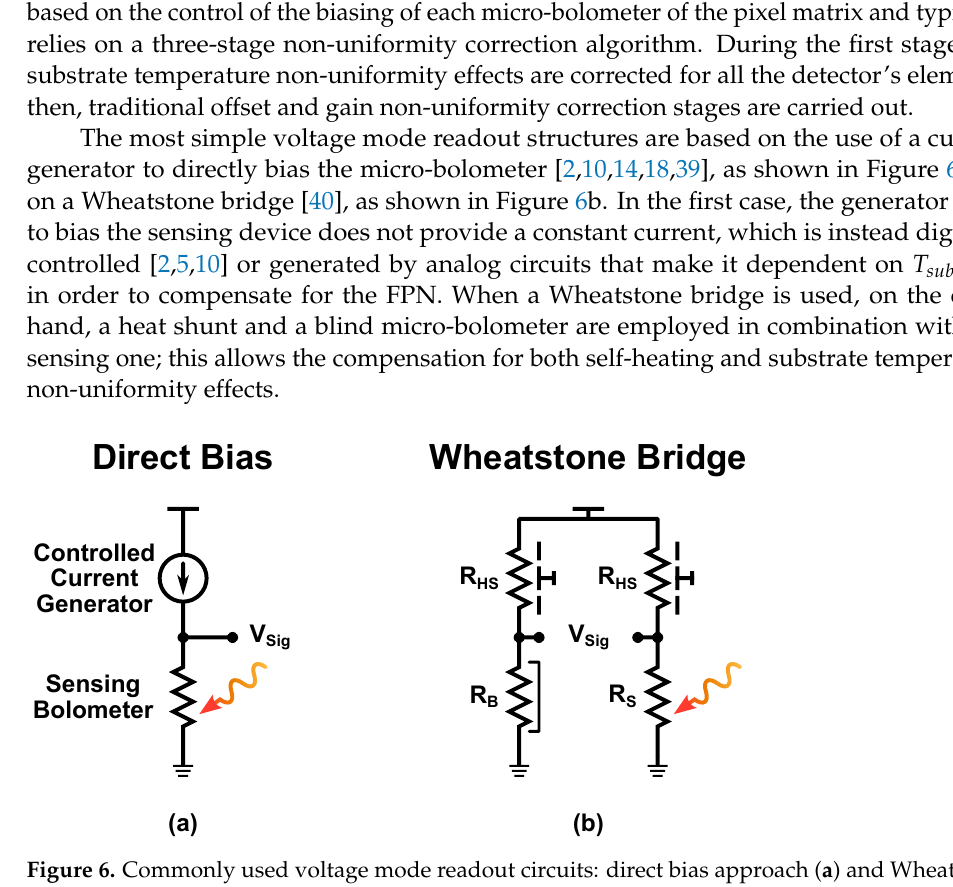
Figure 6. Commonly used voltage mode readout circuits: direct bias approach ( a ) and Wheatstone bridge approach ( b ).